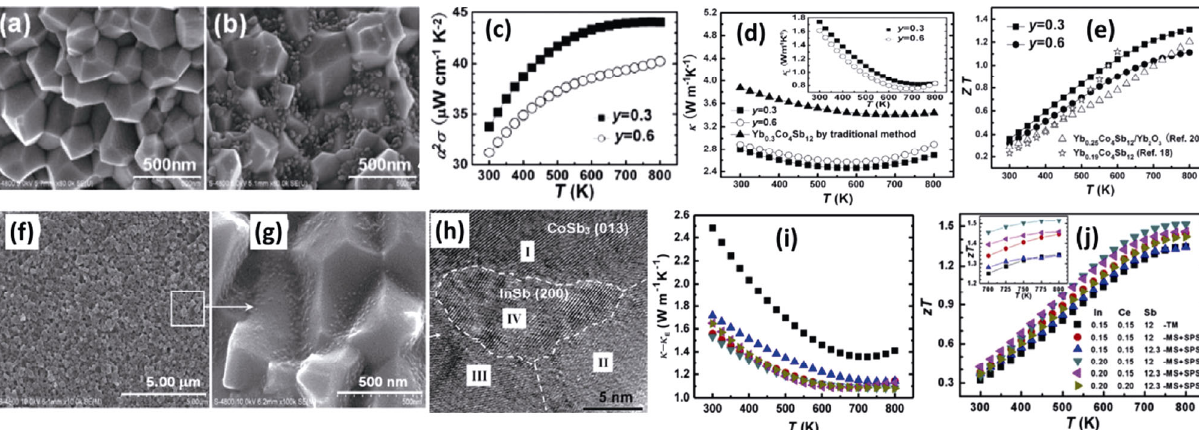
Fig. 14 Nanostructured Yb 0.3 Co 4 Sb 12+ y and In x Ce y Co 4 Sb 12+ z skutterudite TE materials prepared by the MS-SPS. FESEM photographs of bulk nanostructured Yb 0.3 Co 4 Sb 12+ y after SPS: (a) y = 0.3, (b) y = 0.6. Temperature dependences of (c) power factor, (d) thermal conductivity, and (e) ZT values for Yb 0.3 Co 4 Sb 12+ y materials. Reproduced with permission from Ref. [202], © American Institute of Physics 2008. (f, g) FESEM and (h) HRTEM photographs of In 0.15 Ce 0.15 Co 4 Sb 12 sample prepared by MS-SPS; temperature dependences of (i) lattice thermal conductivity and (j) ZT values for In x Ce y Co 4 Sb 12+ z skutterudite TE materials. Reproduced with permission from Ref. [203], © The Chinese Ceramic Society